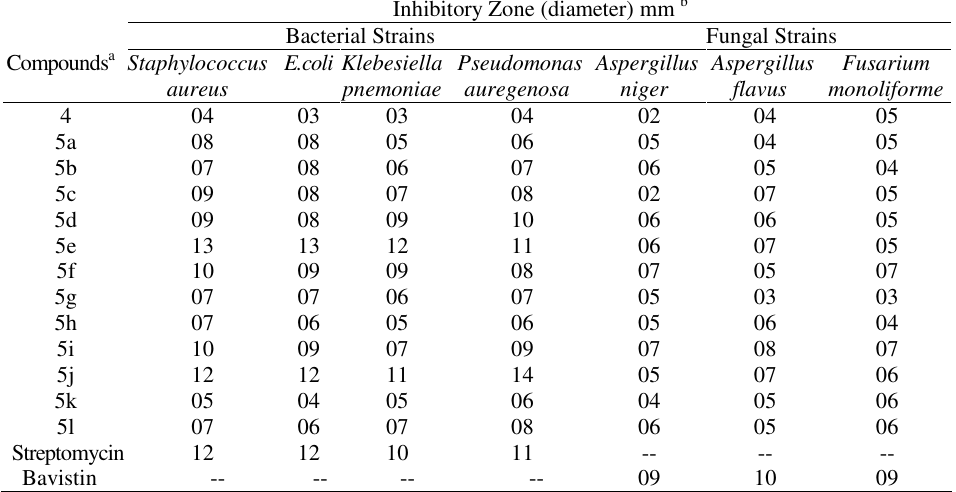
Table 2. Antibacterial and antifungal activity of the synthesized compounds against various bacterial and fungal